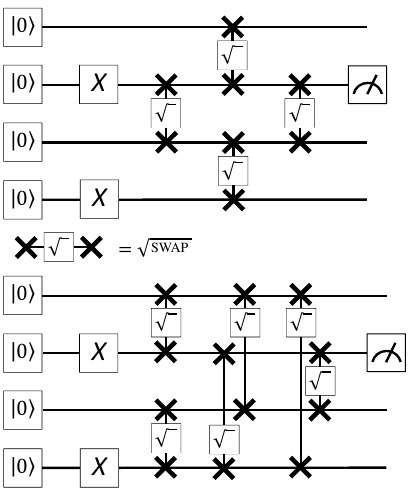
FIG. 4. Quantum circuits depicting the sequences of gates in Eqs. (14) (top) and (17)